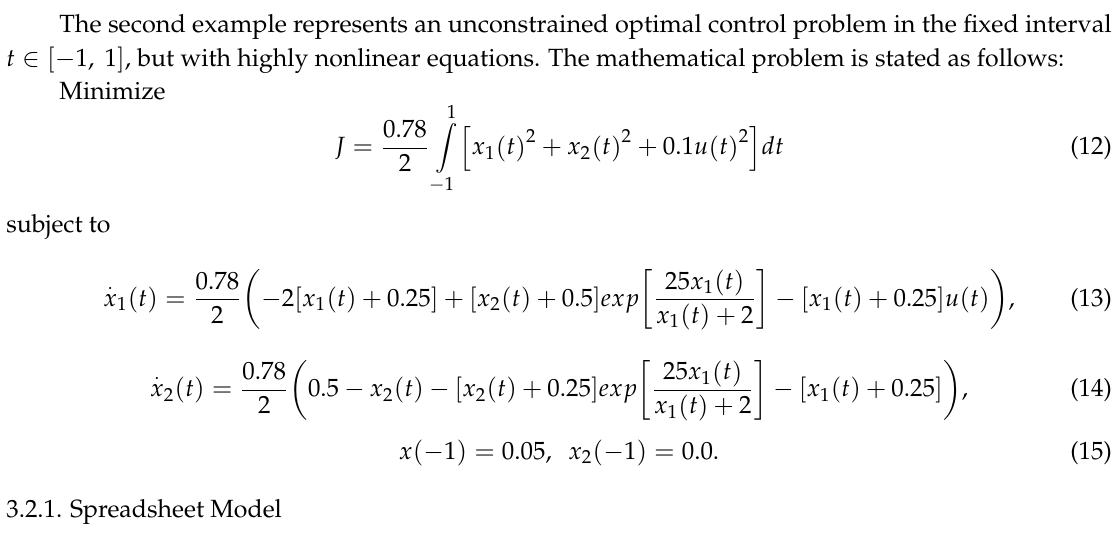
Table 2. Formula definitions used for solving optimal control problem (12)–(15).